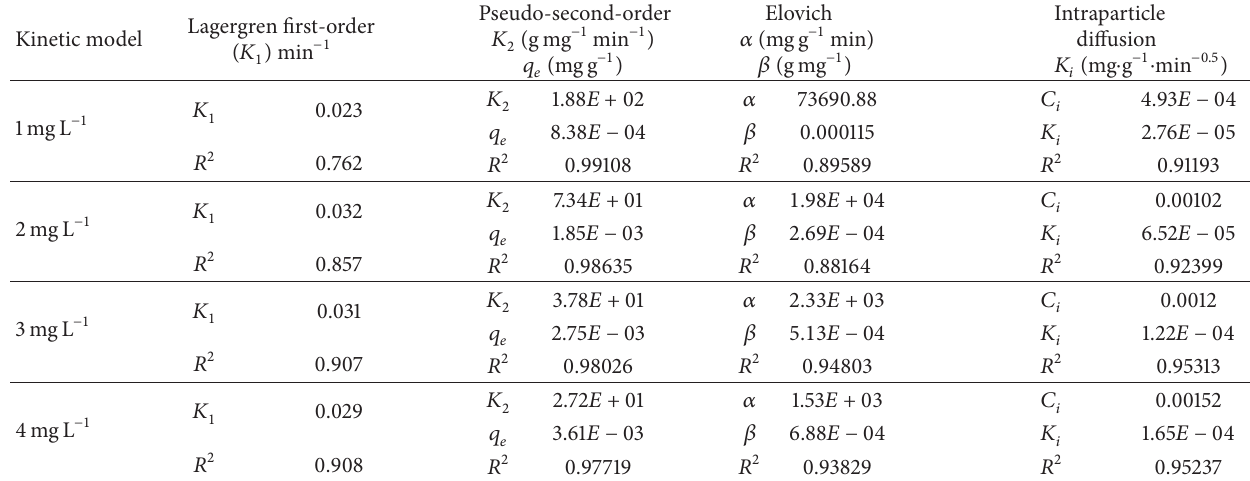
Table 2: Kinetic parameter obtained from theoretical adsorption models.